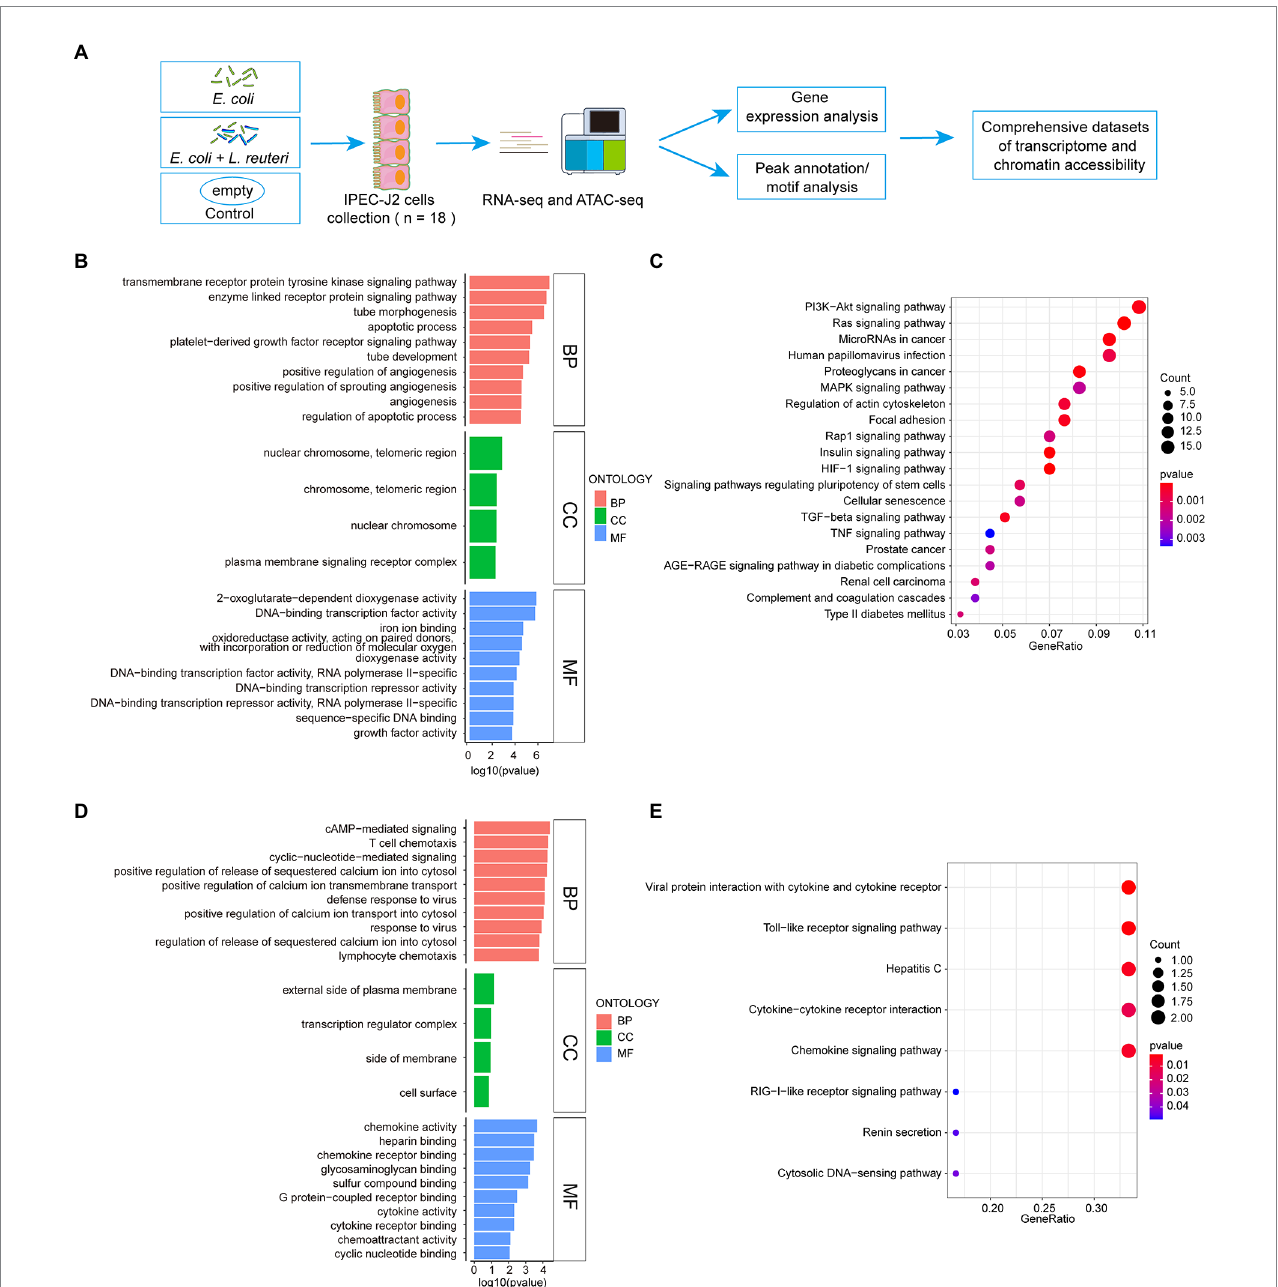
FIGURE 2 Workflow of sequence and enrichment analyses of RNA-seq dataset. (A) Workflow of experimental procedure and sequence analysis. (B,C) GO and KEGG enrichment analyses between E. coli F18ac and control groups. (D,E) GO and KEGG enrichment analyses between E. coli F18ac with and without L. reuteri groups. BP, Biological Process; CC, Cell Component; MF, Molecular